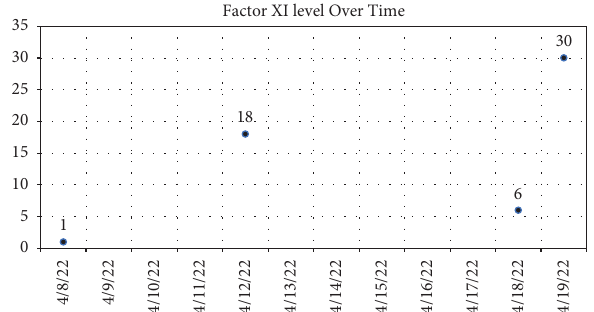
Figure 1: Factor XI activity levels as measured over time. Transfusions 1 and 2 with corresponding allergic reactions took place on 4/8/22. Transfusion 3 with pretransfusion medication to limit allergic reaction symptoms, a total of 2 units, took place on 4/ 11/22. Transfusion 4, similar to transfusion 3, but with 3 units in total took place on 4/12/22. Te CABG took place on 4/19/22.